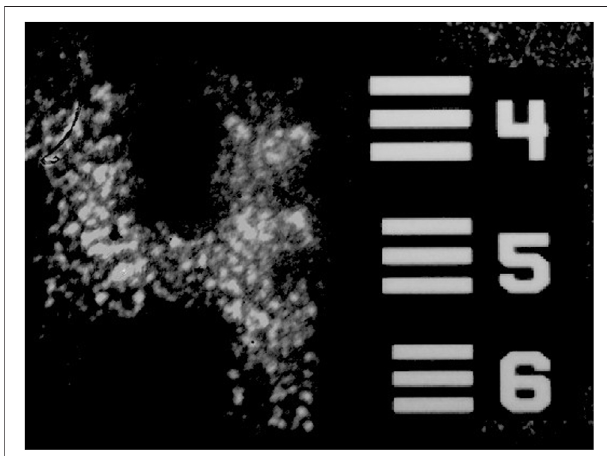
FIGURE 8 | Transported images of numbers “ 4 ” through a 5 cm TALOF is shown along with a section of the 1951 U.S. Air Force resolution test chart (1951-AFTT)usedintheexperiment.Theimageofthenumberis120 µmlong. Details can be obtained in Reference [4].